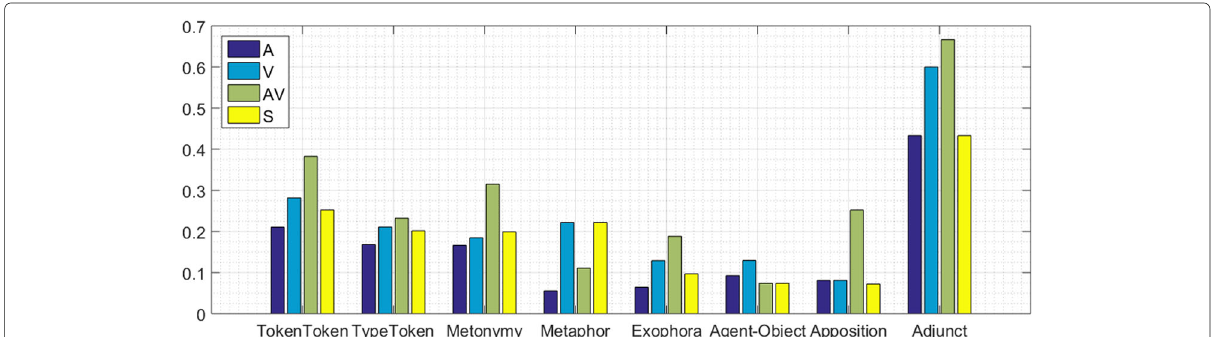
Fig. 4 Correlation between annotation of saliency and COSMOROE annotation. From left to right : Token-Token, Metonymy part for whole, Compl. Exophora Ess., and Compl. Agent-object